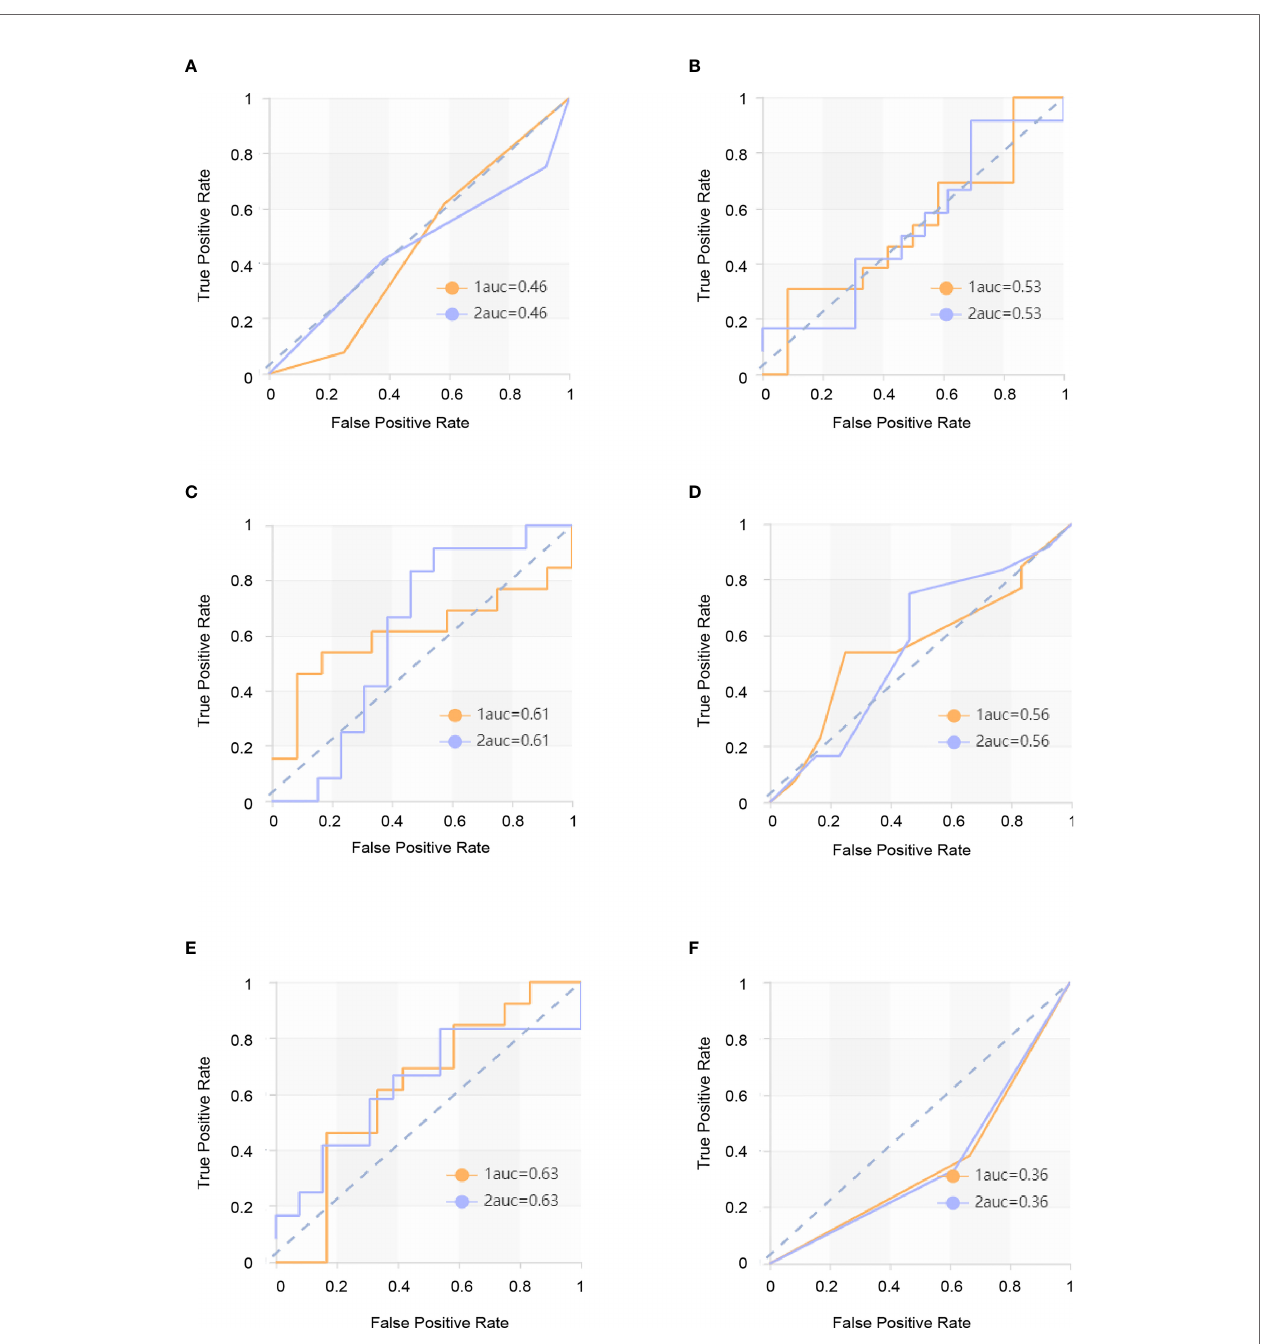
FIGURE 3 | ROC curves in delayed phase. The yellow curve is the poor prognosis group (PP group), and the blue curve is the good prognosis group (GP group). (A) ROC curve of the KNN model in the validation set. The AUC were 0.462 in the PP group (sensitivity and speci fi city were 0.62 and 0.42, respectively) and 0.462 in the GP group (sensitivity and speci fi city were 0.42 and 0.62, respectively). (B) ROC curve of the SVM model in the validation set. The AUC were 0.532 in the PP group (sensitivity and speci fi city were 0.54 and 0.50) and 0.532 in the GP group (sensitivity and speci fi city were 0.50 and 0.54, respectively). (C) ROC curve of the XGBoost model in the validation set. The AUC were 0.609 in the PP group (sensitivity and speci fi city were 0.62 and 0.50, respectively) and 0.609 in the GP group (sensitivity and speci fi city were 0.50 and 0.62, respectively). (D) ROC curve of the RF model in the validation set. The AUC were 0.564 in the PP group (sensitivity and speci fi city were 0.54 and 0.58, respectively) and 0.564 in the GP group (sensitivity and speci fi city were 0.58 and 0.54, respectively). (E) ROC curve of the LR model in the validation set. The AUC were 0.628 in the PP group (sensitivity and speci fi city were 0.62 and 0.67, respectively) 0.578 in the GP group (sensitivity and speci fi city were 0.67 and 0.62, respectively). (F) ROC curve of the DT model in the validation set. The AUC were 0.359 in the PP group (sensitivity and speci fi city were 0.38 and 0.33, respectively) and 0.528 in the GP group (sensitivity and speci fi city were 0.33 and 0.38,